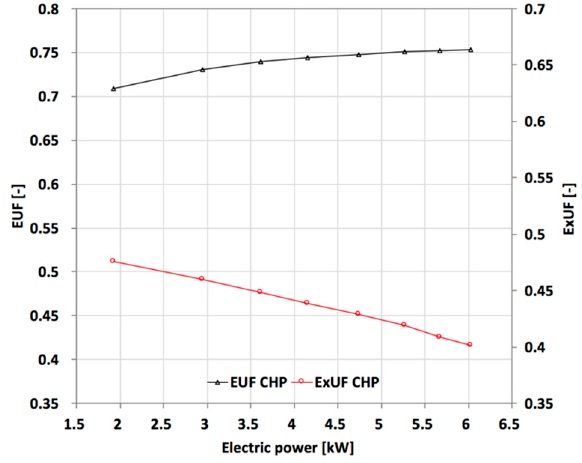
Figure 7. Energy Utilization Factor (EUF) and Exergy Utilization Factor (ExUF) vs. electric power for CHP mode.